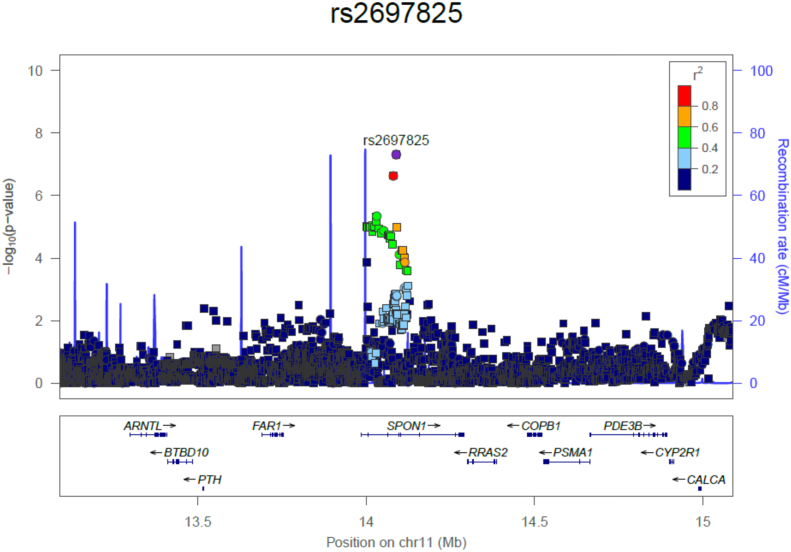
SPON1 regional association plot of the unexplained HBM cases and AOGC Low BMD controls in a quantitative trait GWAS of total hip BMD Z-Score, adjusted for age, age2 and centre (1000 kb either side of rs2697825 shown). Square symbols indicate imputed SNPs; circles indicate those genotyped.